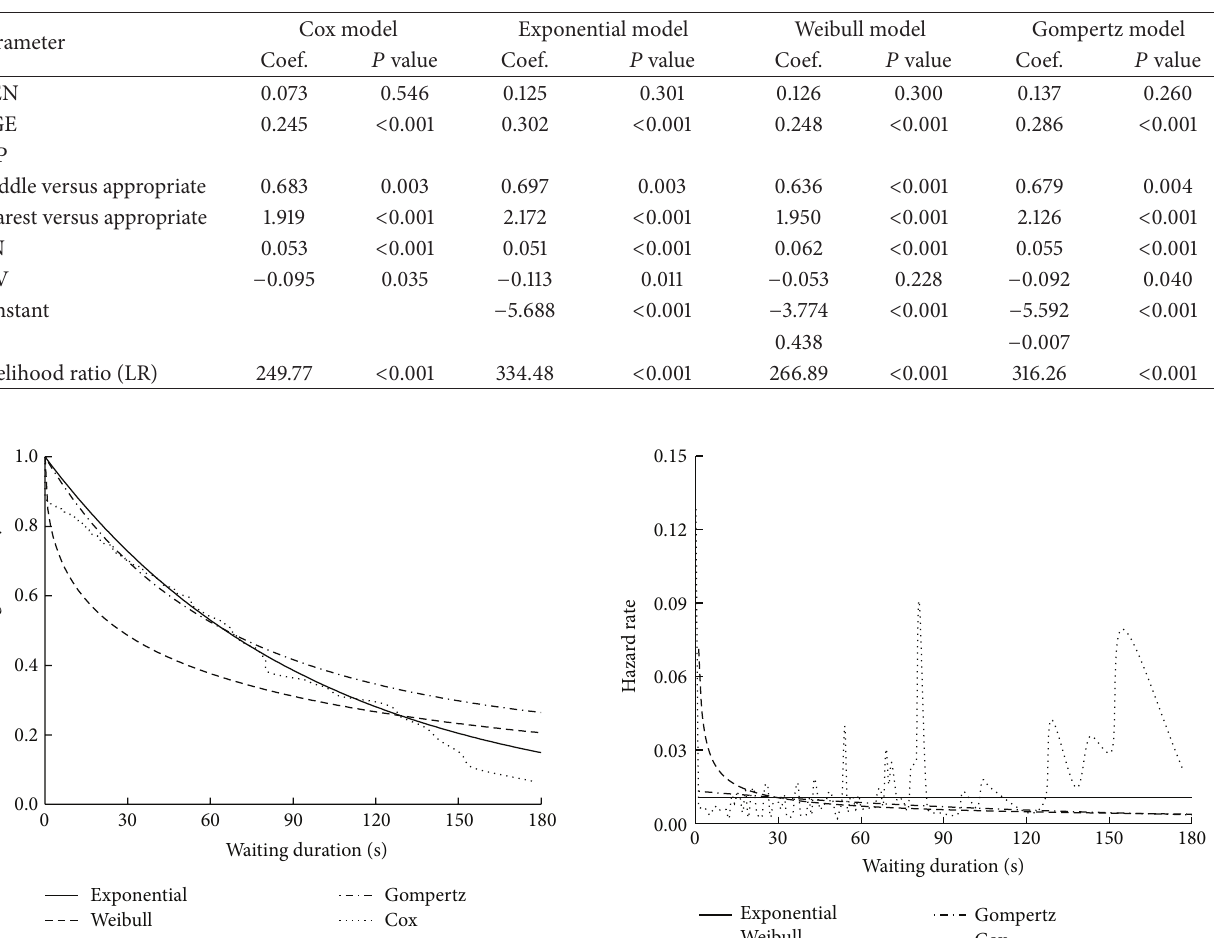
Table 2: Parameter estimation in waiting duration model.